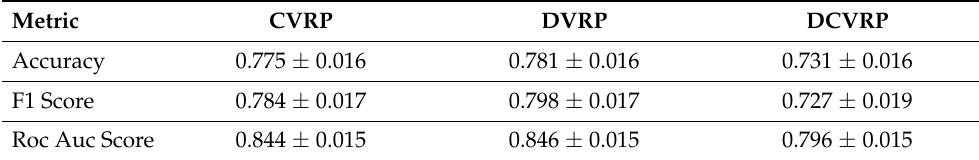
Table 6. Classification summary for Logistic Regression to predict difficulty for local search.